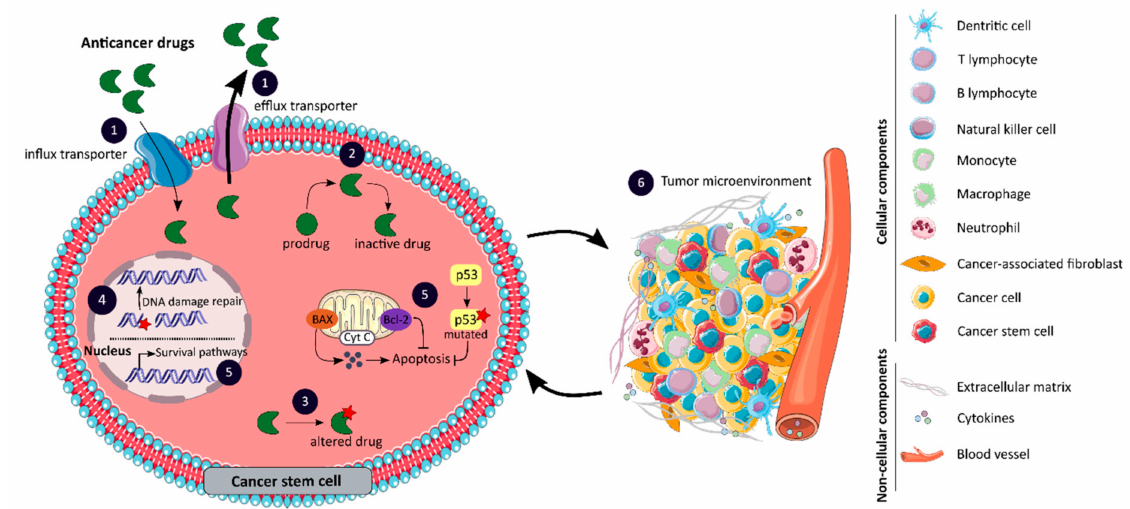
Figure 4. Major mechanisms of anticancer drug resistance attributed to CSCs such as changes in drug transport (1); impaired drug metabolism (2); alterations in drug targets (3); enhanced DNA damage repair (4); impaired balance between apoptosis and survival pathways (5); and the role of the tumor microenvironment comprising cellular and non-cellular components (6). CSC: cancer stem cell; DNA: deoxyribonucleic